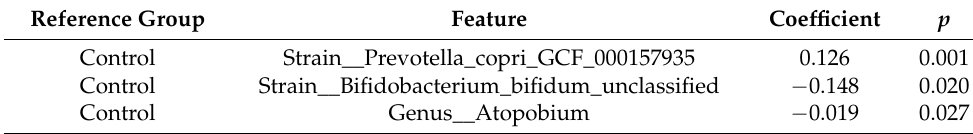
Table 5. Results of multiple linear analyses of bacterial flora.